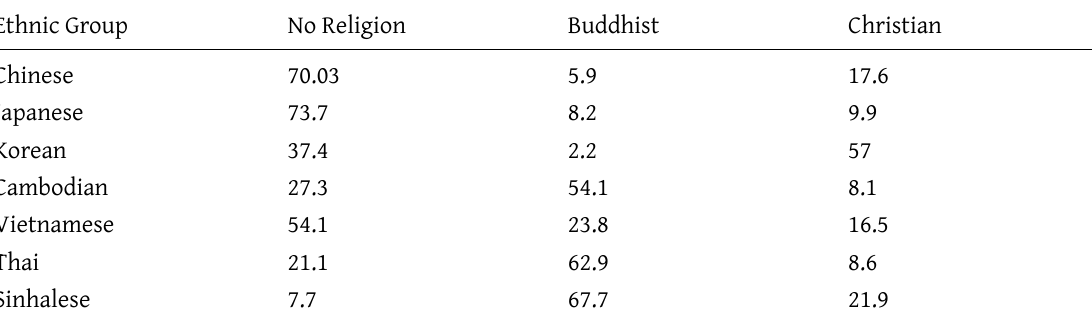
Table 3: Religious Identification by Ethnic Group (New Zealand Census